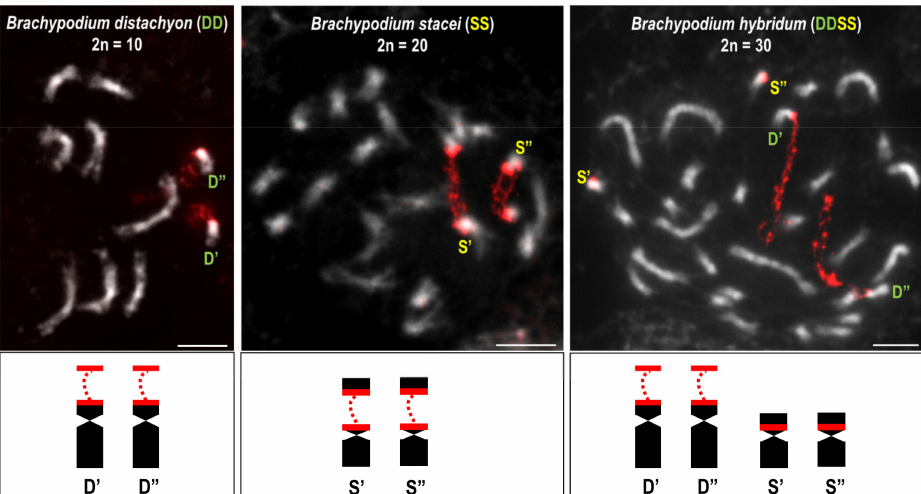
Figure 5. FISH with 25S rDNA (red fluorescence) as a probe on the mitotic prometaphase chromo- somes of two diploid and one allotetraploid Brachypodium species ( B. distachyon and B. stacei are considered to be the putative progenitors of the allotetraploid B. hybridum based on [57,97,111,201]. Note the presence of secondary constrictions on one chromosomal pair in each species. The highly condensed rDNA loci in B. hybridum (derived from B. stacei and marked as S’ and S”) are transcription- ally silenced via nucleolar dominance, thus they do not form secondary constrictions. D’ and D”—the B. distachyon or B. distachyon -inherited 35S rDNA loci; S’ and S”—the B. stacei or B. stacei -inherited 35S rDNA loci. Scale bars 5 µ